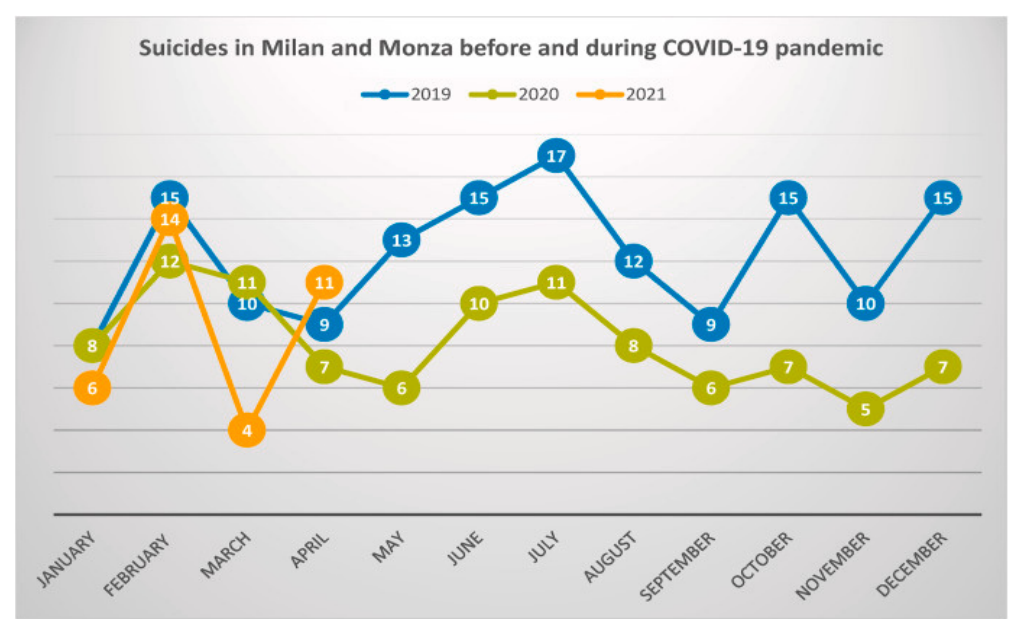
Figure 18. Suicides in Milan before and during